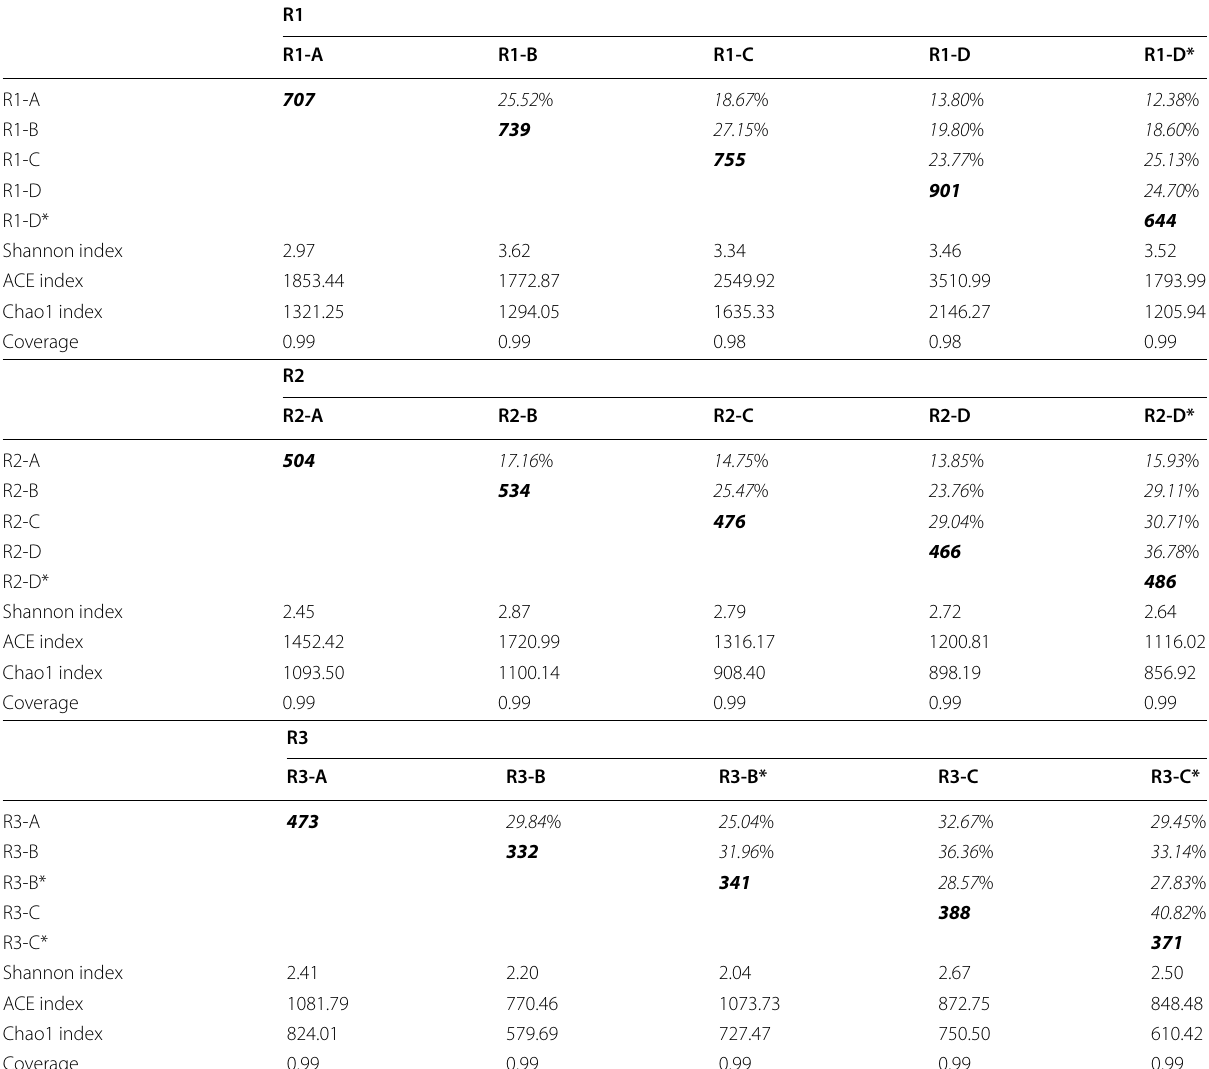
Table 1 The unique OTU numbers, percentages of shared OTU and α-diversity of three treatment PBS reactors